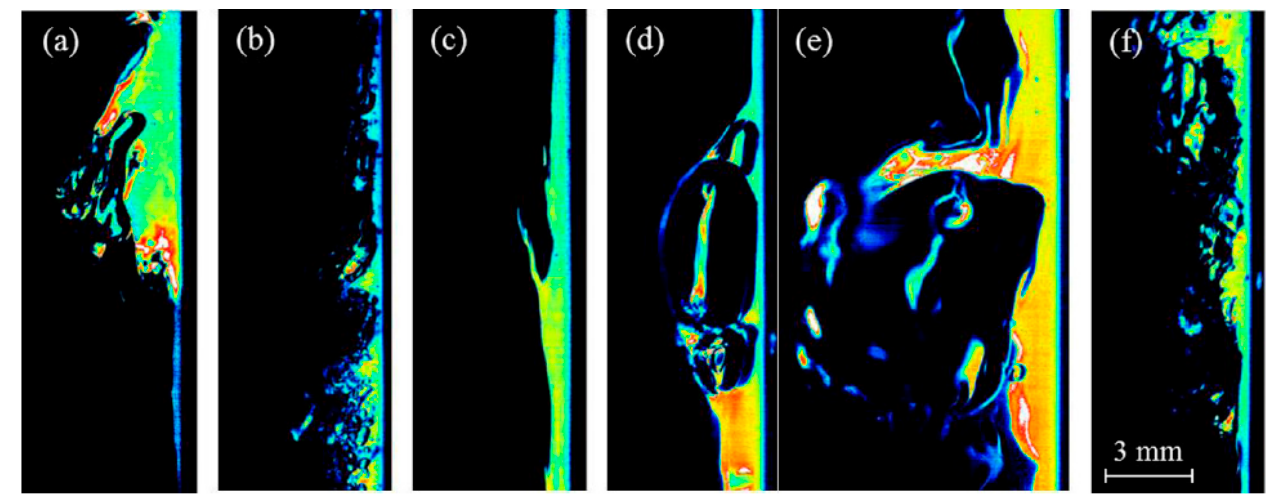
Figure 7. PLIF-images of downward annular flow [49]. The presented events are interpreted as: shearing-off disturbance wave crests ( a ); disturbance wave undercutting ( b ); liquid ligament ( c ); bubble burst ( d – e ); droplet impingement ( f ).